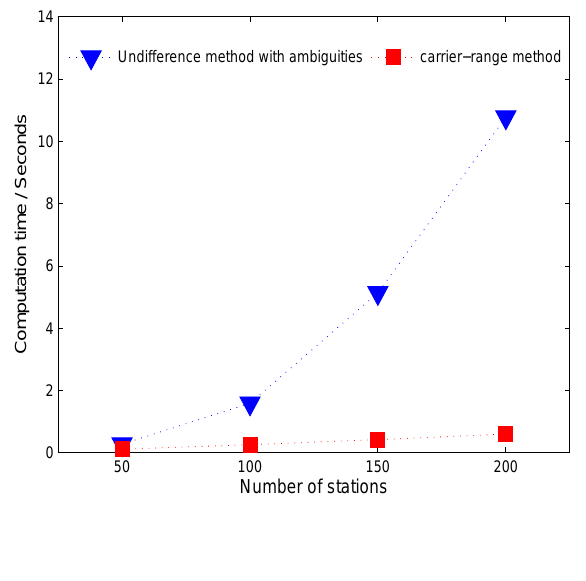
Figure 5. Comparison of average computation time per epoch of the new method (red squares) and traditional method (blue triangles) for networks with different number of